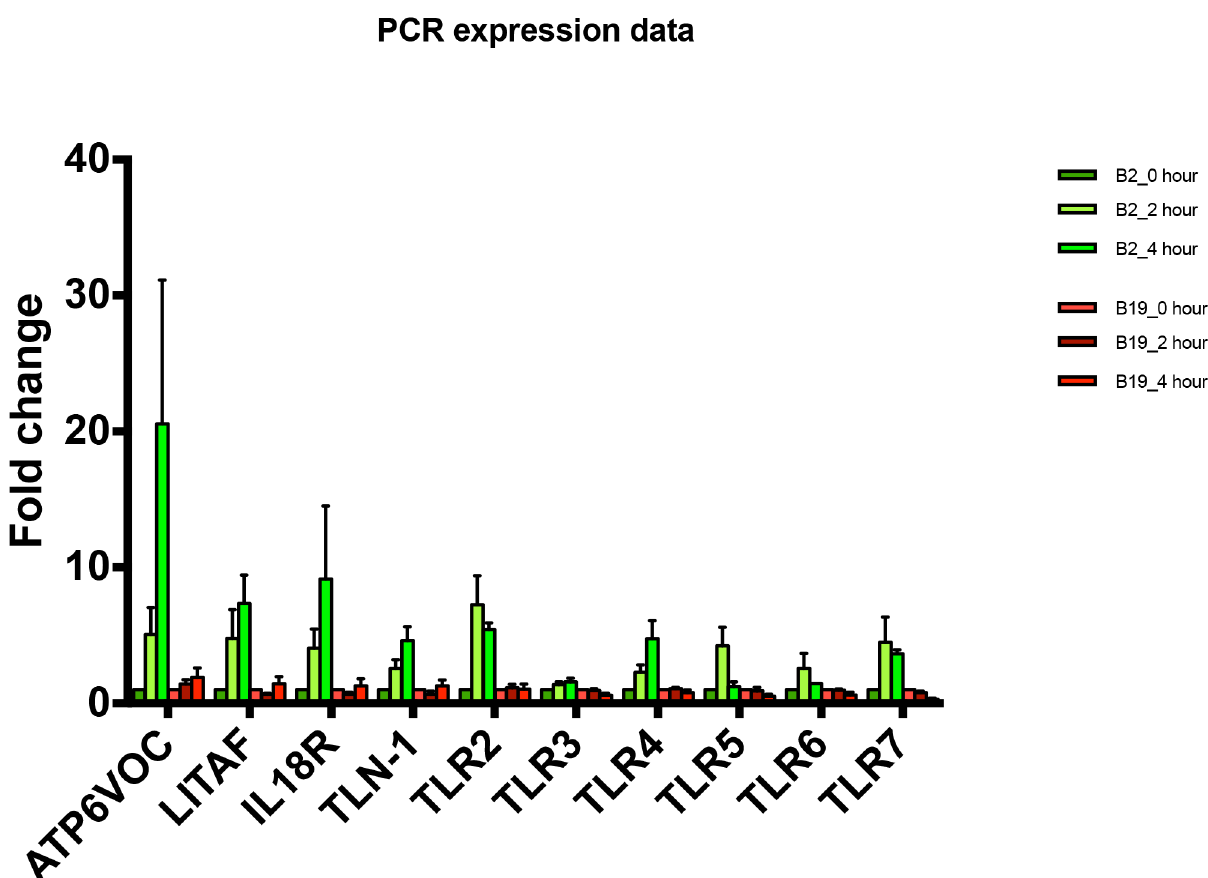
Fig 4. RT-PCR validation of transcripts identified as significantly expressedin RNA sequencing data. Gene expressionfor ATP6V0C, LITAF, IL18R, TLN-1, TLR2, TLR3, TLR4, TLR5, TLR6, and TLR7 was assessedin B2 and B19 monocytes/macrophages followingstimulationwith IFN γ . Expression was measuredat 0 hours, 2 hours and 4 hours. Expression for transcripts in B2 cells are shown in green and expressionfor transcripts are shown in red. Standard error is shown for each value. Valueswere considered statistically significantwith p <